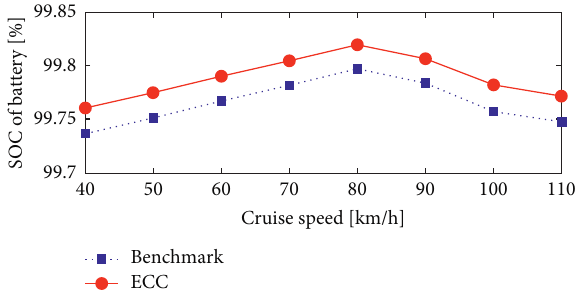
Figure 14: Battery SOC at different cruise